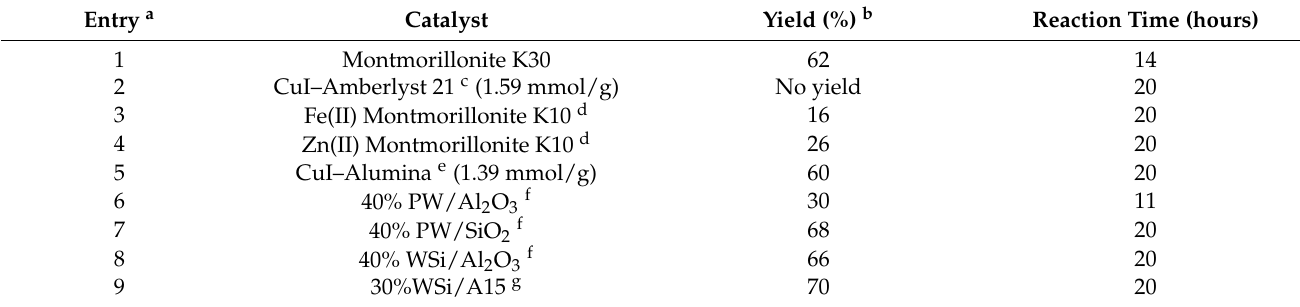
Table 1. Catalyst screening for the model reaction involving benzaldehyde ( 1a ), methyl acetoacetate ( 2a ) and urea ( 3 ). Entry a Catalyst Yield (%) b Montmorillonite